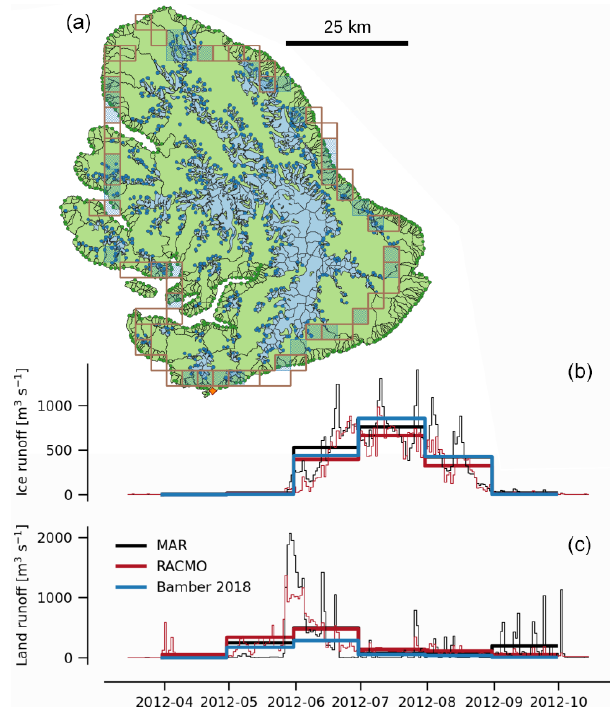
Figure 6. Disko Island comparison between this product and Bam- ber et al. (2018). Light green are land basins with dark green outlet dots. Light blue are ice basins with dark blue outlet dots. Brown and hatched blue 5km 2 cells are the land and ice runoff locations, re- spectively, from Bamber et al. (2018). Bottom graphs show ice (b) and land (c) runoff for the 2012 runoff calendar